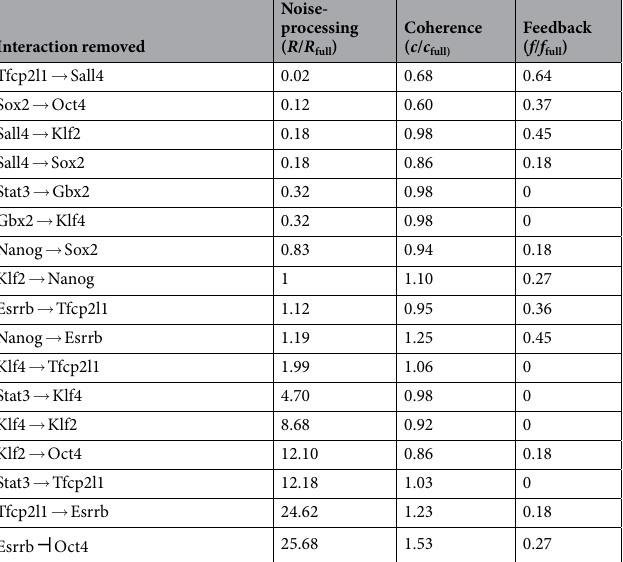
Table 1. The effect that targeted removal of interactions on network noise-processing. The first column identifies the edge removed from the network; the second column shows the effect of targeted removal of the given edge on the ratio R by comparison with that of the unperturbed network; the third column shows the effect of targeted removal of the given edge has on network coherence; the fourth column shows the effect of targeted removal of the given edge has on network feedback. Edges that emanate from Oct4 do not contribute to the noise processing capacity of the network and their removal does not affect R so they are excluded from this table. Since all paths from Lif to Oct4 pass through the edge Lif → Stat3 its removal disconnects the network; this edge is also accordingly excluded from the table. Interactions are ordered by column